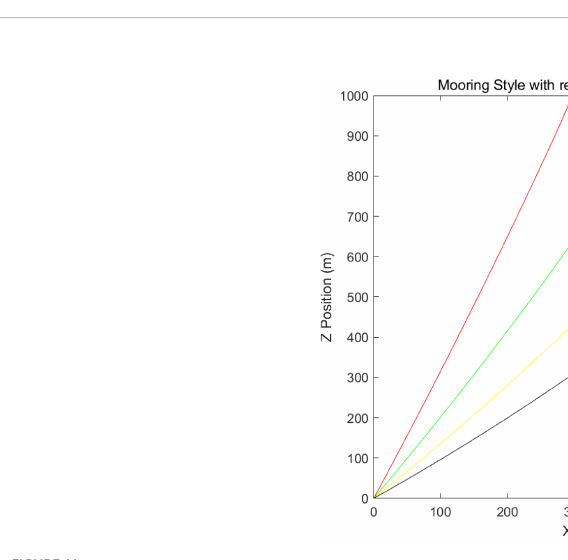
FIGURE 11 Shape of the mooring line for different lengths of snubber for a Nilspin cable with the snubber